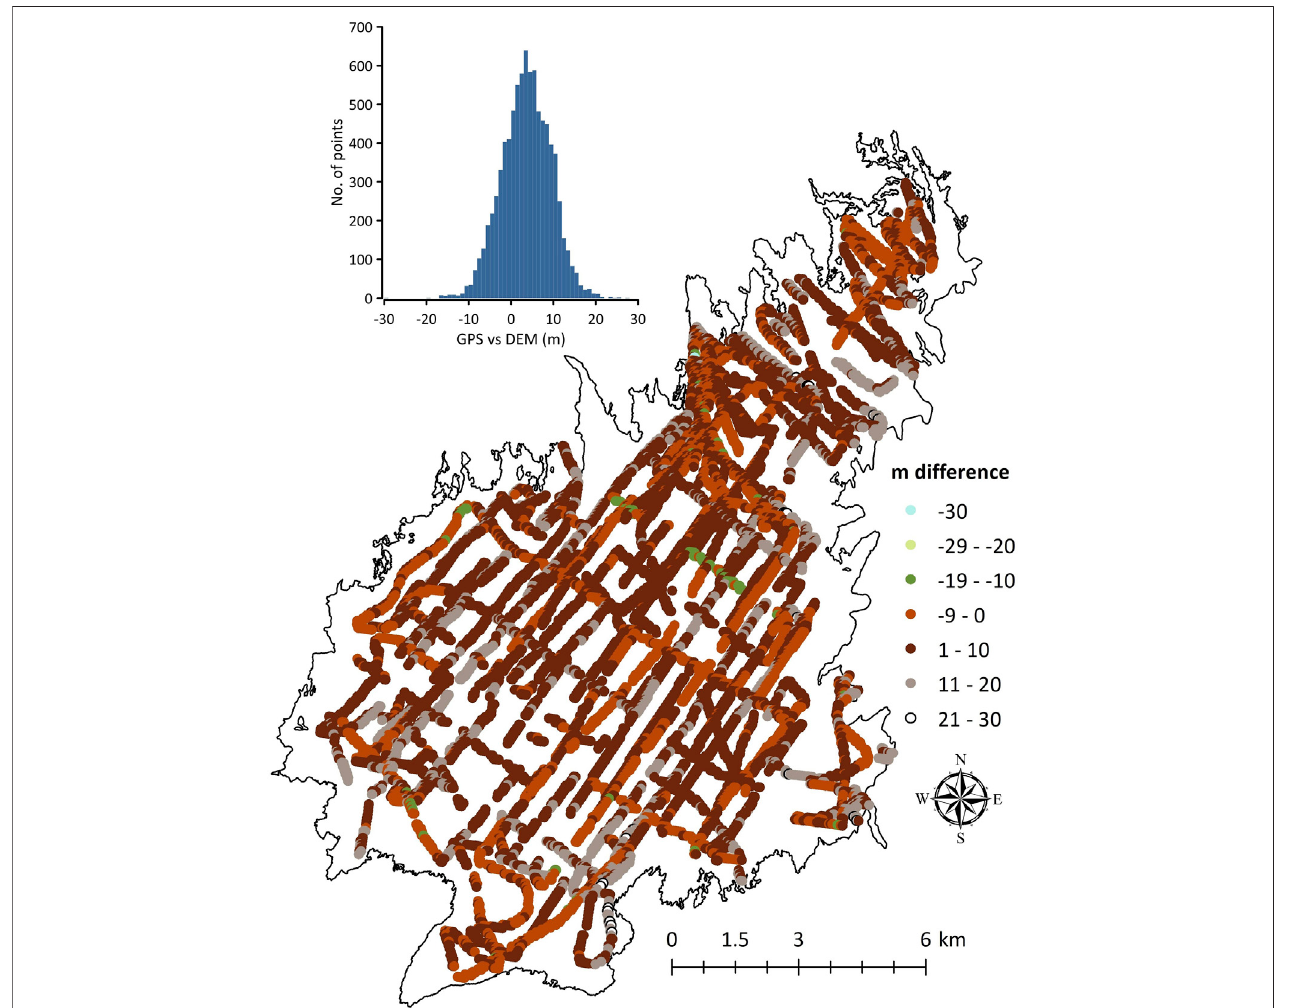
FIGURE 3 | The coloured lines illustrate the calculated differences in elevation between the values measured by the ice-penetrating radar GPS and the 2013 DEM (Kartverket/norgeskart.no, 2020). The histogram (top left) shows the distribution of elevation differences. Most of the data have a difference of less than 10 m.